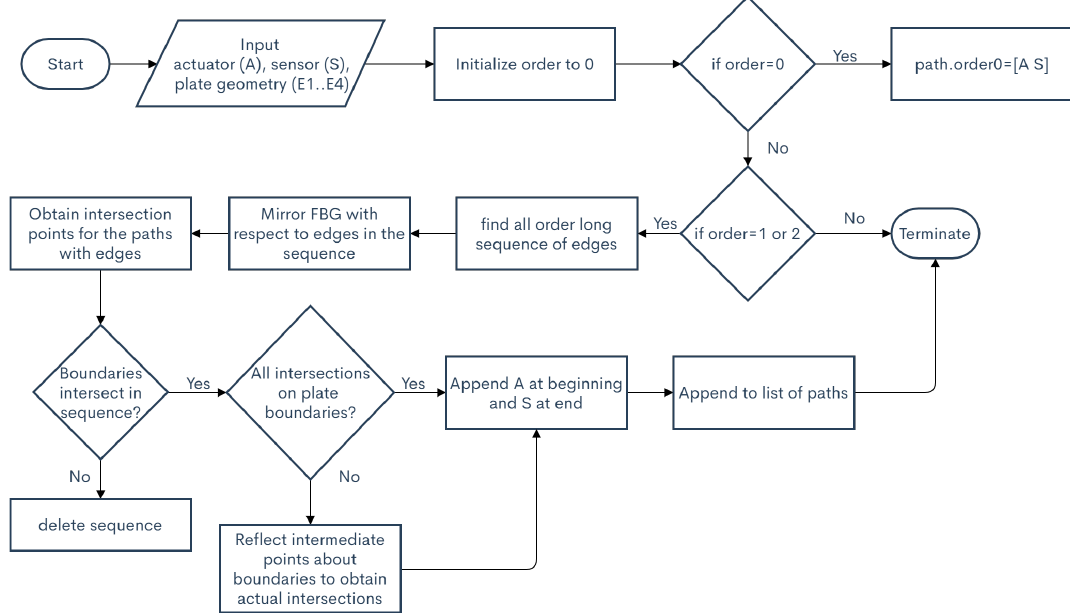
Figure 3. Flowchart for obtaining reflection paths.